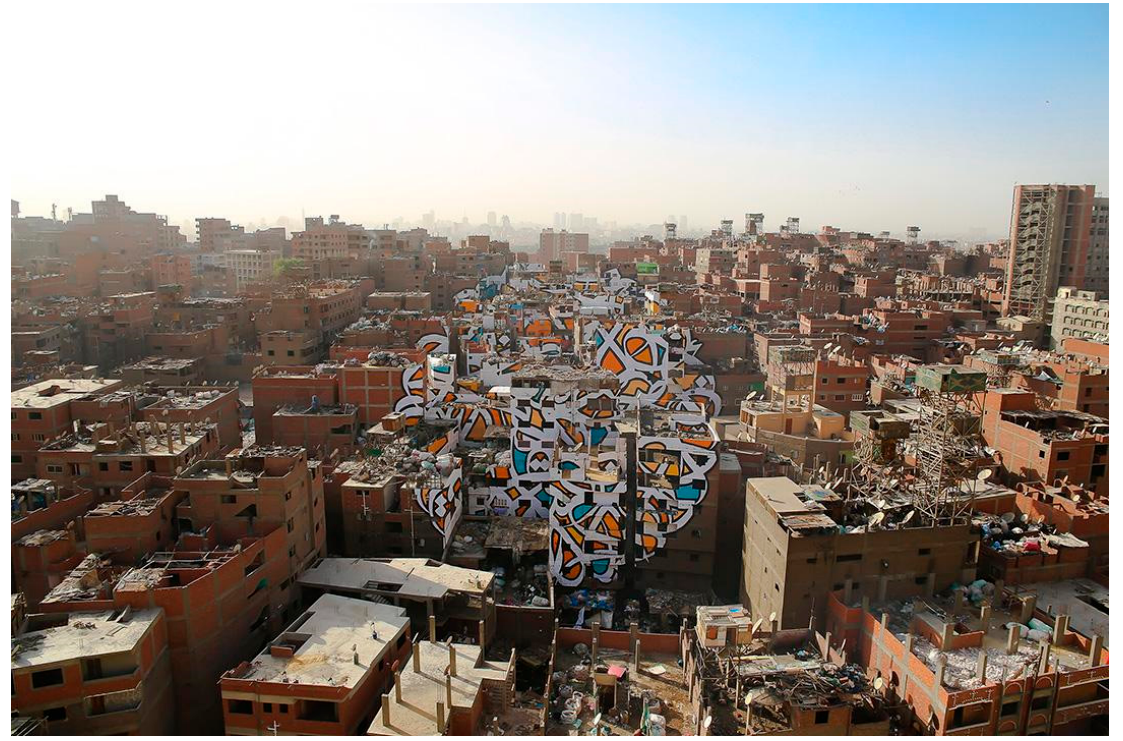
Figure 1. Photo of eL Seed’s Perspective calligraffiti artwork in Cairo, Egypt (Photo by Ouahidb https://en.wikipedia.org/wiki/EL_Seed#/media/File:Zaraeeb.jpg).